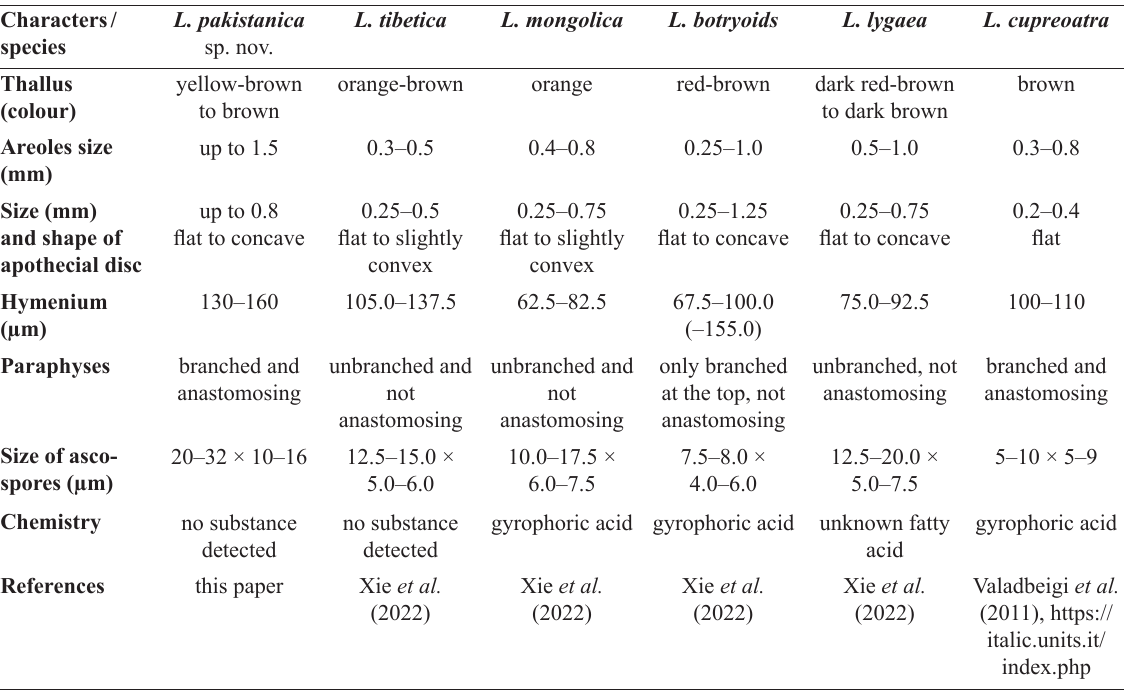
Table 2. Comparison of L. pakistanica sp. nov. and related species of Lecaimmeria C.M.Xie, Lu L.Zhang